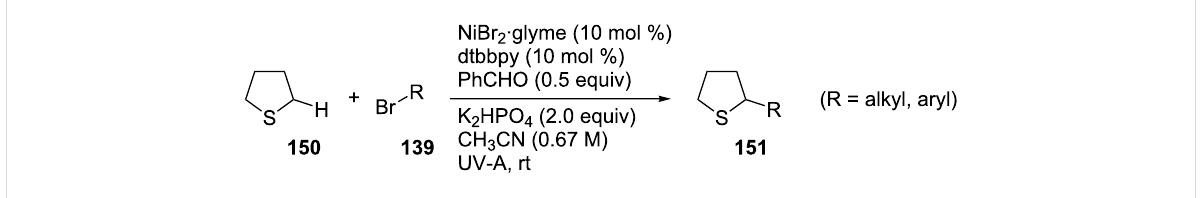
Scheme 34: C(sp 3 )–H functionalization of